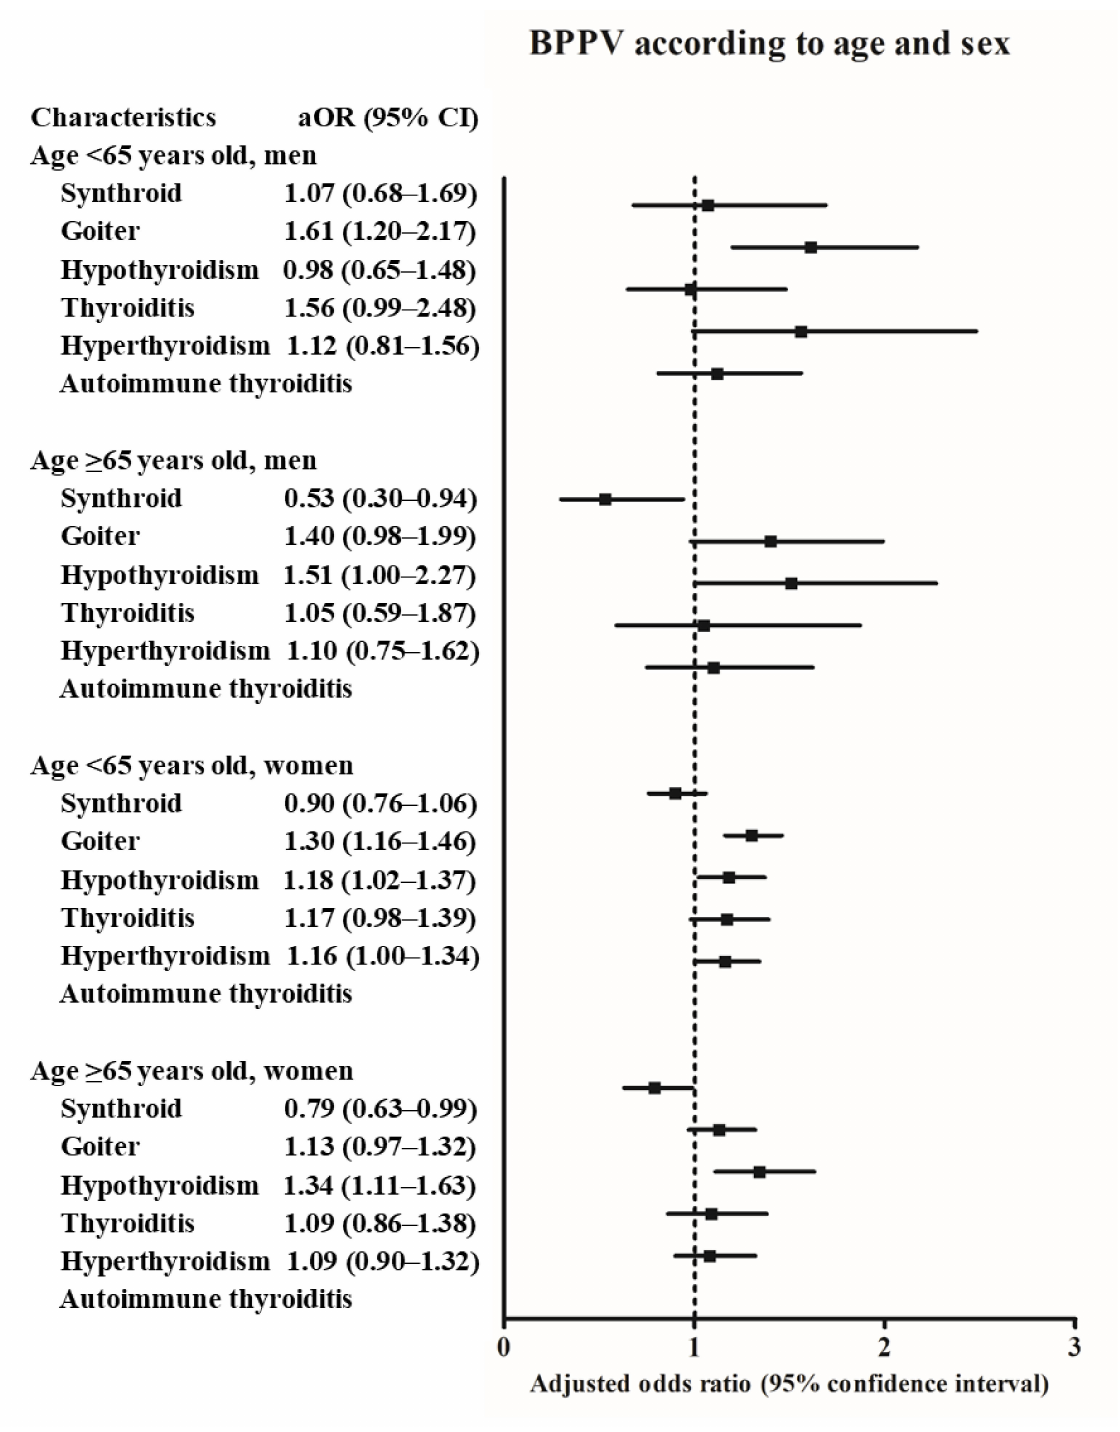
Figure 2. The odds ratios (95% confidence interval) of levothyroxine medication, goiter, hypothyroidism, thyroiditis, hyperthyroidism, and autoimmune thyroiditis for benign paroxysmal positional vertigo according to age and